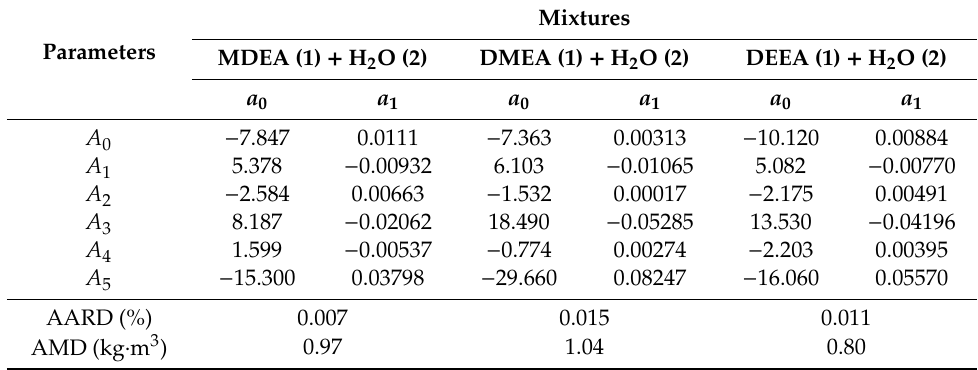
Table 4. Temperature dependency of the Redlich–Kister coe ffi cients ( A i ) for the excess molar